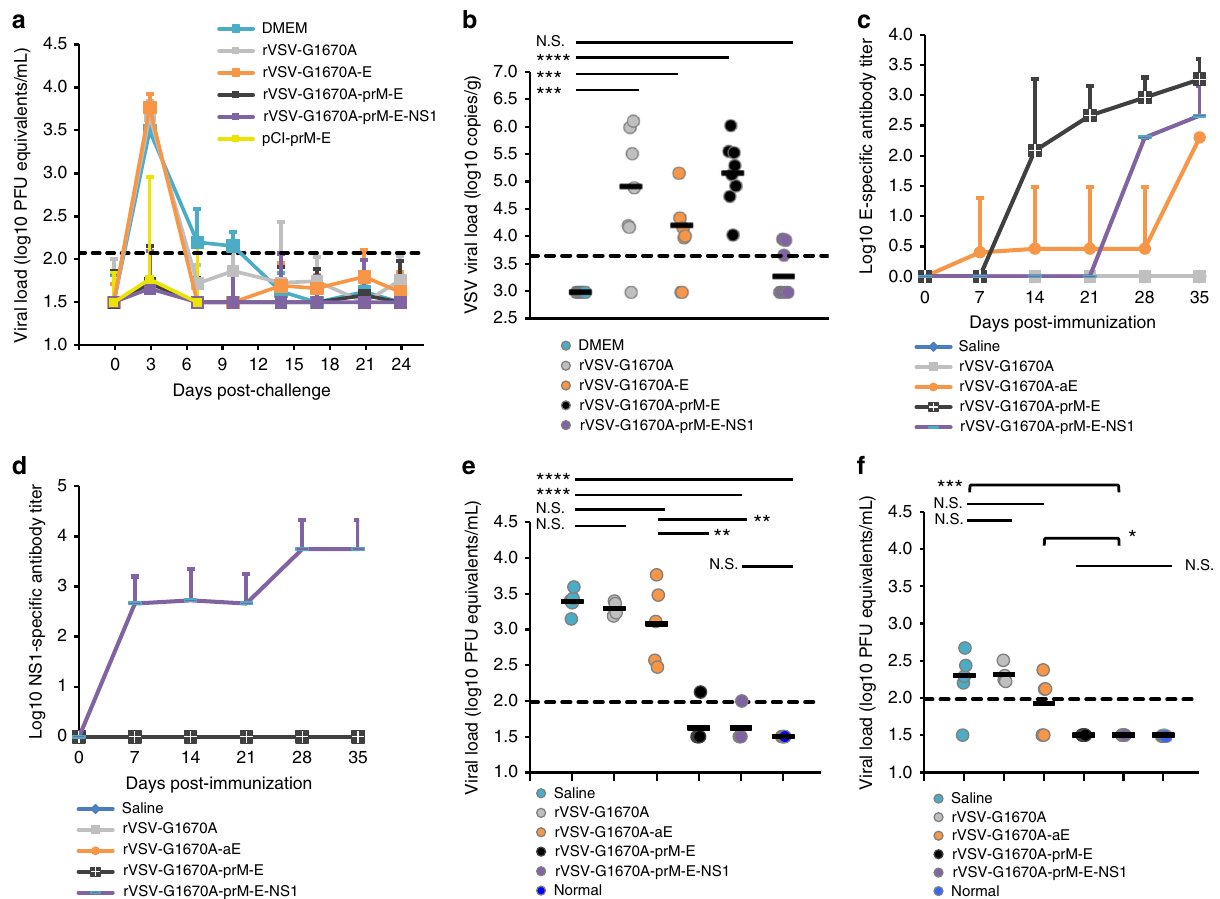
Fig. 4 MTase-defective rVSV (mtdVSV)-based vaccine protects BALB/c mice from viremia. Mice were intranasally inoculated with DMEM or a single dose (10 6 PFU) of each recombinant virus. For DNA vaccine, mice were vaccinated intramuscularly with 50 µ g of pCI-prM-E, and were boosted with the same dose two weeks later. At week 5, mice were intraperitoneally administered 1.8 mg of anti-IFNAR1 blocking antibody and 24 h later challenged intravenously with 10 6 PFU of ZIKV Cambodian strain. a Dynamic of viremia in unimmunized mice after challenge with ZIKV. After challenge, blood samples were collected at the indicated time until day 24 and the presence of ZIKV RNA was quantitated by real-time RT-PCR and calculated to PFU equivalent RNA/ml. Data were expressed as GMT of 10 mice ± standard deviation. b Quanti fi cation of VSV RNA in BALB/c mice. Brains were harvested at the termination of the study. The VSV RNA was measured by real-time RT-PCR using primers annealing to the VSV L gene. Data were expressed together with the GMT of 10 mice (black bars). P value (by Student ’ s t -test) from top to bottom: **** P = 4.25 × 10 − 7 , *** P = 0.000710, *** P = 0.000371. c Kinetics of ZIKV E-speci fi c antibody induced by mtdVSV expressing ZIKV antigen. Serum samples were collected weekly and analyzed by ELISA for ZIKV-speci fi c serum IgG Ab. Data are expressed as the GMT of fi ve mice ± standard deviation. d Kinetics of ZIKV NS1-speci fi c antibody induced by mtdVSV expressing ZIKV antigen. e mtdVSV-based vaccine protects BALB/c mice from viremia at day 3 post-challenge. The level of viremia was measured by real-time RT-PCR at day 3 post-challenge. P value (by Student ’ s t -test) from top to bottom: **** P = 1.02 × 10 − 5 , **** P = 6.06 × 10 − 5 , ** P = 0.00345, *** P = 0.00310. f mtdVSV- based vaccine protects BALB/c mice from viremia at day 7 post-challenge. The level of viremia was measured by real-time RT-PCR at day 7 post-challenge. P value (by Student ’ s t -test) from top to bottom: *** P = 3.89 × 10 − 5 , * P = 0.0201. Signi fi cance was calculated using t -test. N.S. indicates not signi fi